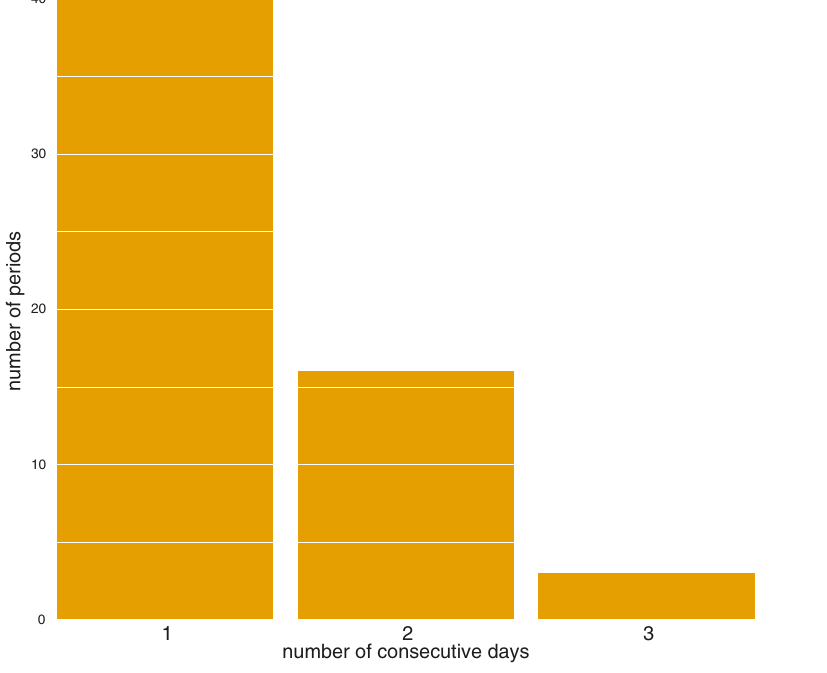
Figure 7. The distribution of non-overlaping periods with freezing rain between 1980–2018 based on SYNOP observation from B˘aneasa weather